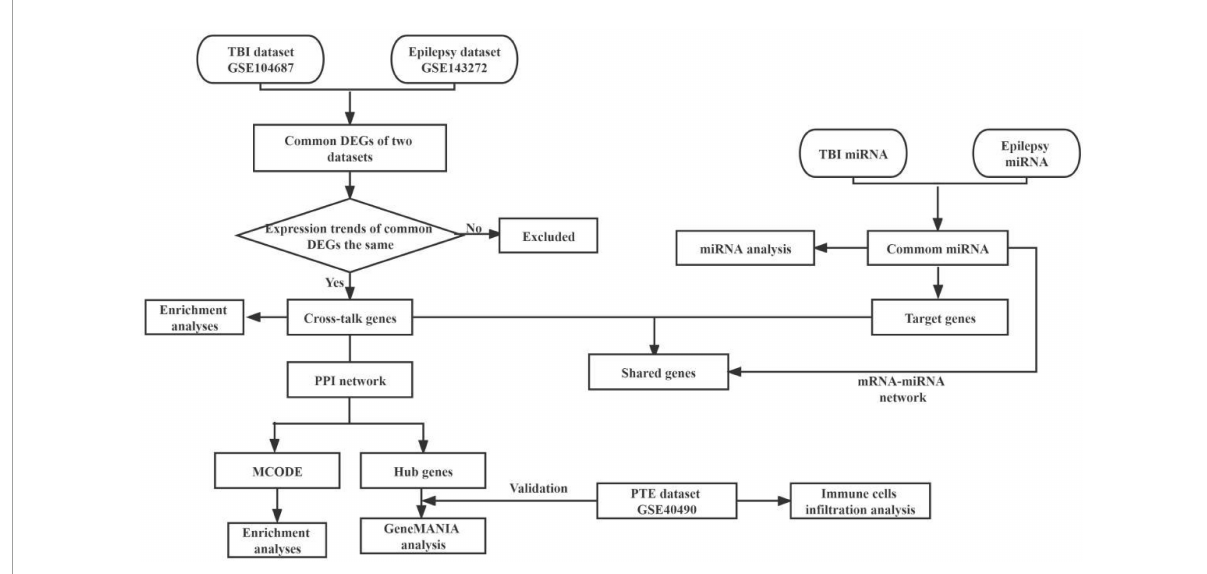
FIGURE1 The workflow of present bioinformatics analysis. TBI, traumatic brain injury; DEGs, differentially expressed genes; GO, gene ontology; KEGG, Kyoto Encyclopedia of Genes and Genomes; PPI, protein–protein interactions; MCODE, molecular complex detection; PTE, post-traumatic